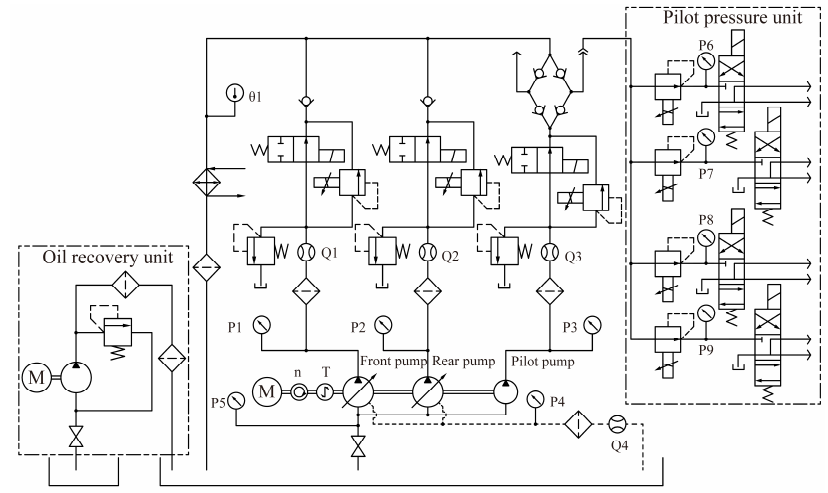
Figure 10. Schematic diagram of performance test system for the double-compound axial piston pump.